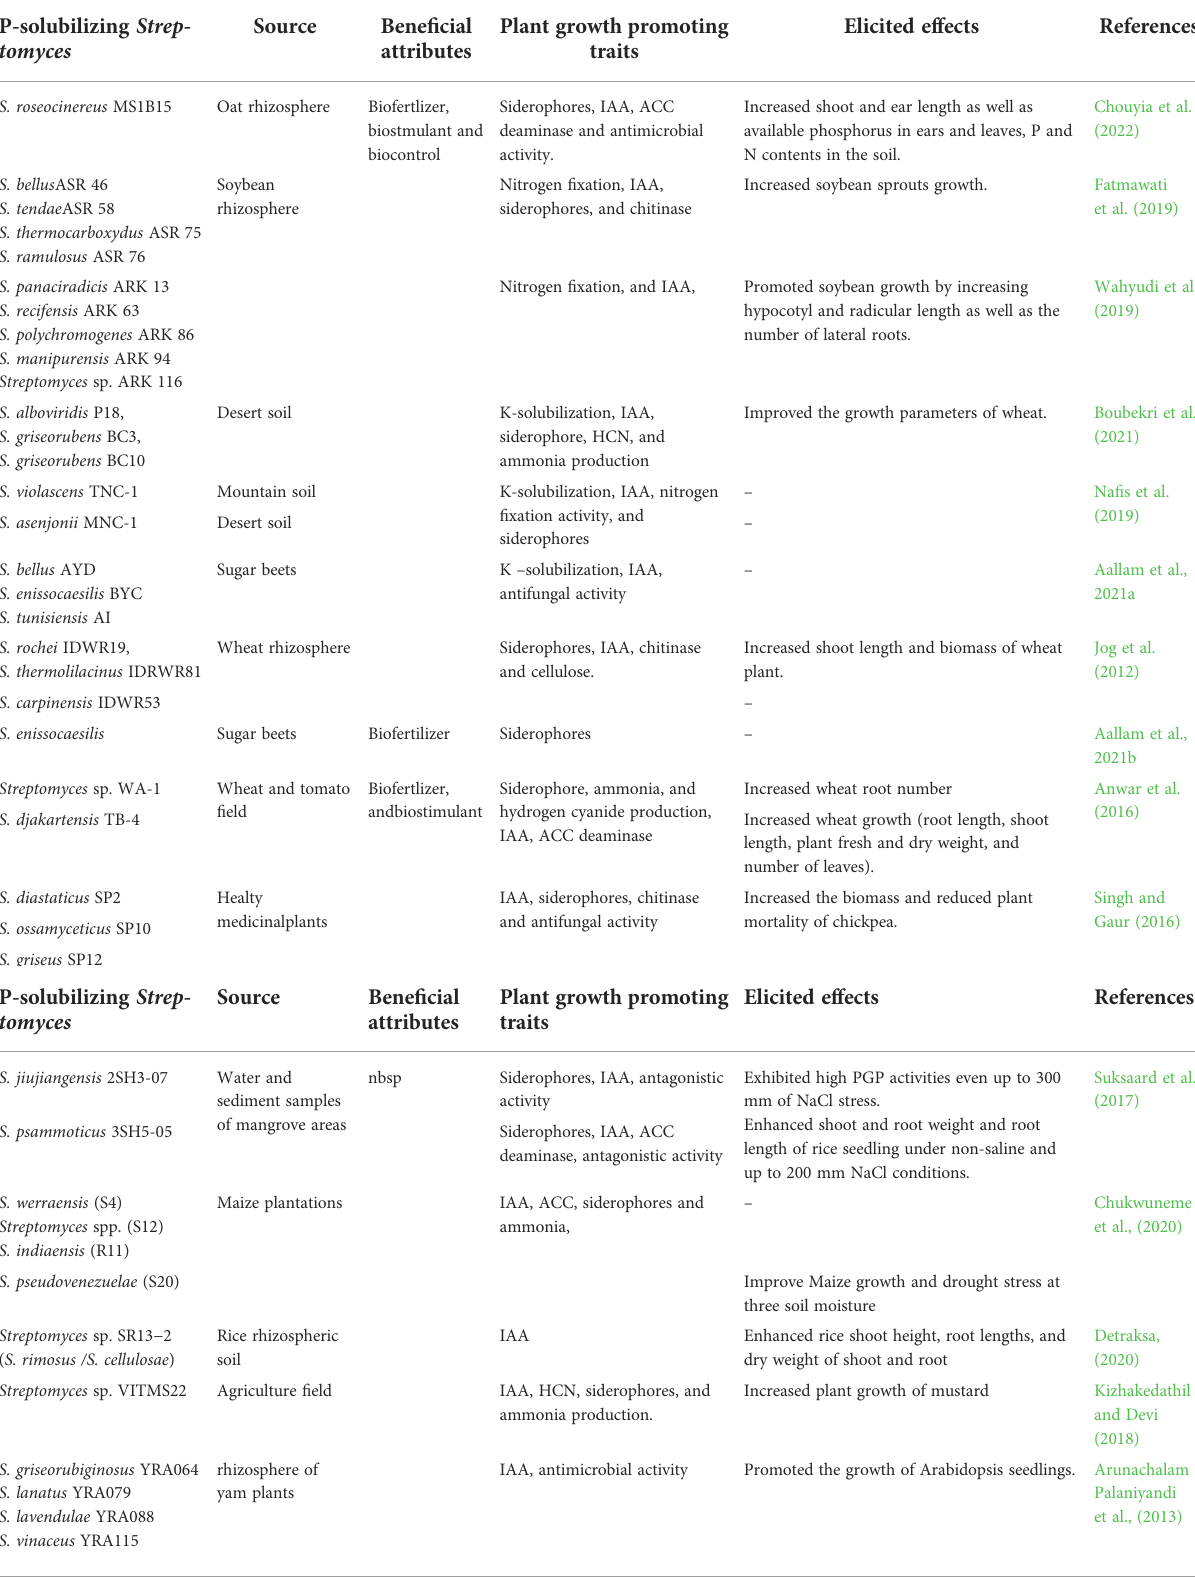
TABLE 2 Studies on the plant growth promoting traits released by P-solubilizing Streptomyces species within past 10